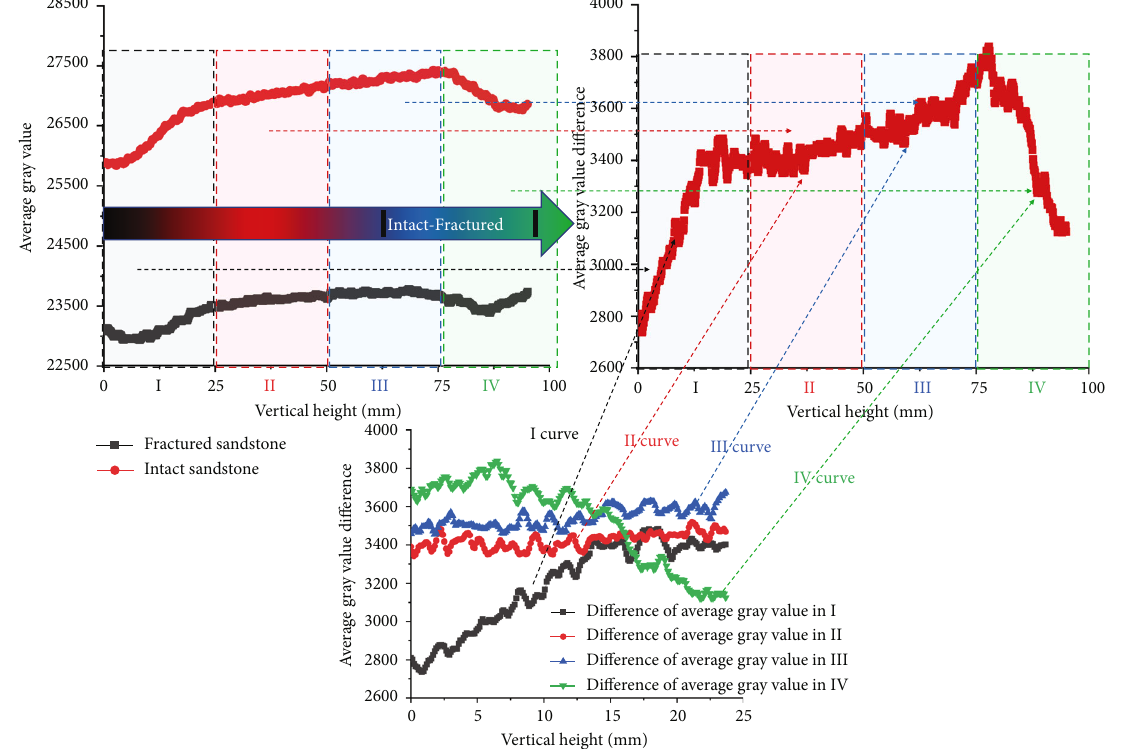
Figure 12: Comparison of average gray value of sandstone specimens before and after